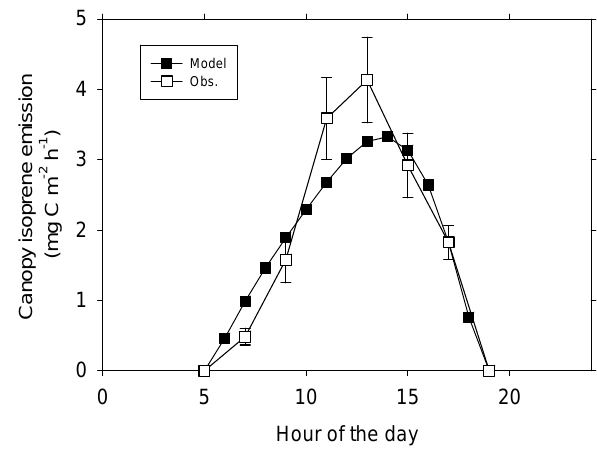
Fig. 9. Comparison between modelled isoprene emission rates for the Harvard forest site in a clear atmosphere with observations (Goldstein et al., 1998). Bars indicate standard errors of observa- tions averaged over 2h time